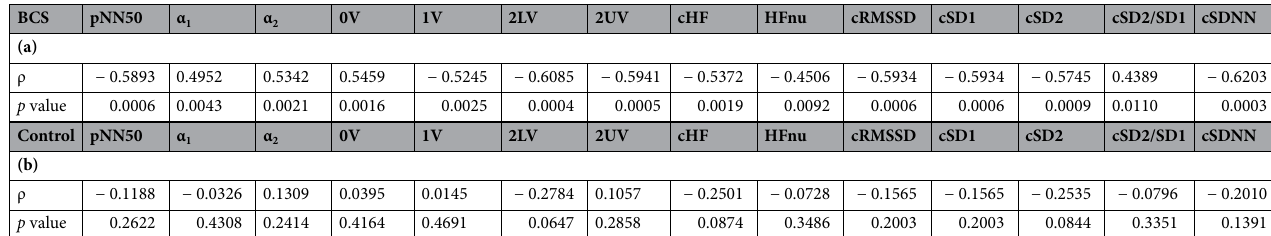
Table 4. Spearman correlations between normalized visceral fat rating (nVFR) and linear and nonlinear HRV indexes in (a) breast cancer survivors (BCS) and (b) Control group. In every cell, the top row indicates the Spearman’s correlation coefficient (ρ), and the bottom row indicates the